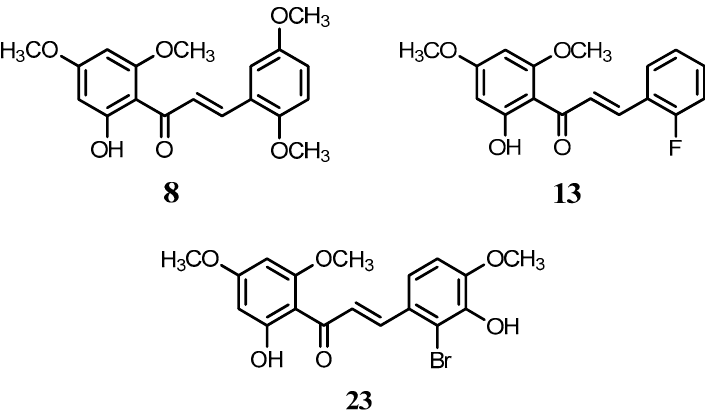
Figure 1. The structure of compounds 8 , 13 and 23 .